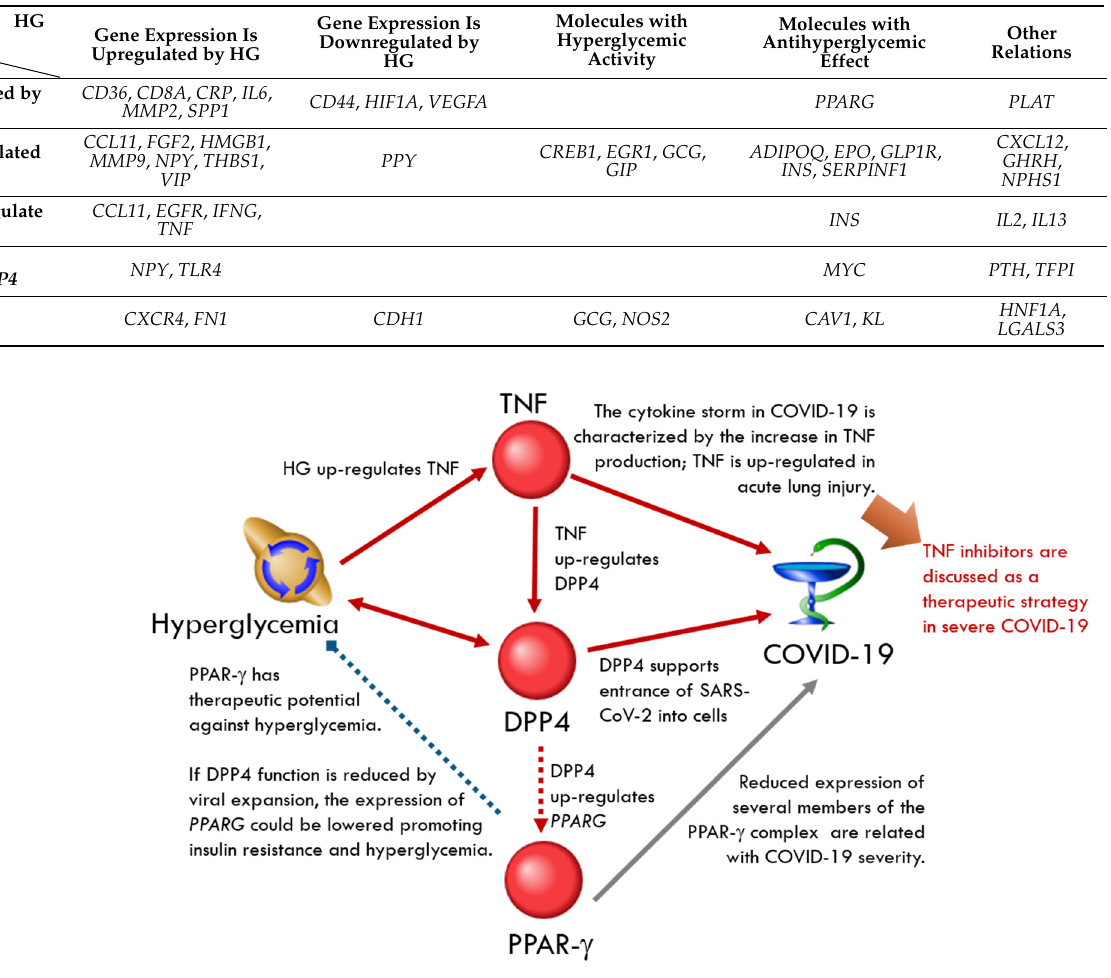
Figure 5. The feedback loop in DPP4-related network involves TNF and PPAR- γ . The red arrows correspond to the up-regulation, the blue arrow corresponds to the down-regulation and the grey arrow corresponds to the association.